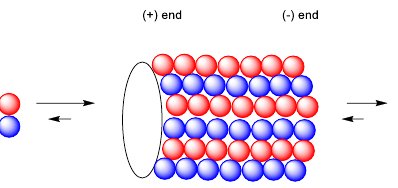
Figure 15. Dynamic state of the microtubule continuously prolonged by complexing or shortened by and dissociating heterodimer tubules from the microtubule [5,60].